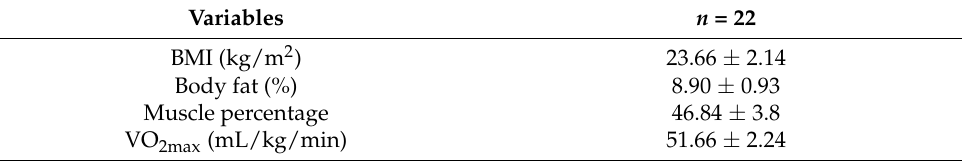
Table 1. Physical characteristics of